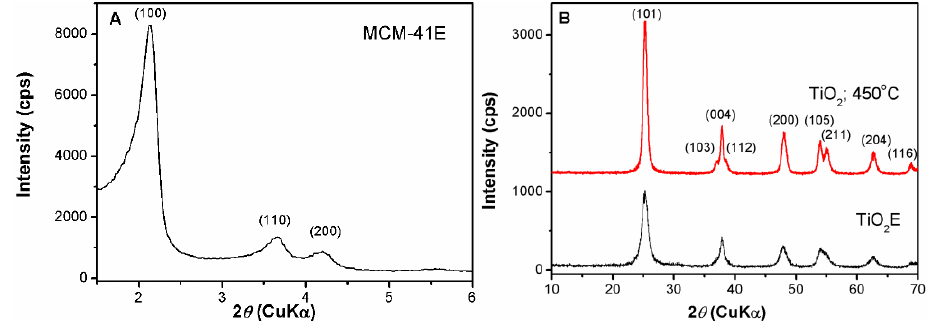
Figure 3. ( A ) Small-angle XRD analysis of MCM-41E and ( B ) wide-angle XRD patterns of TiO 2 E and TiO 2 calcined at 450 °C.